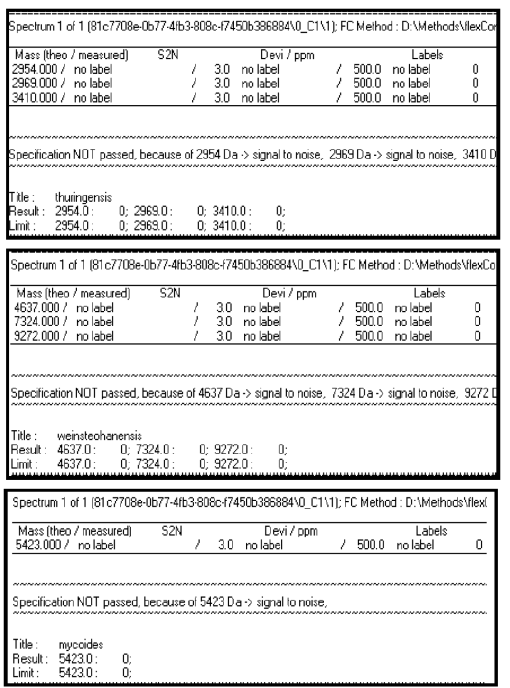
Figure 7. Results of FlexAnalysis algorithms for all the considered species, applied to an experimental spectrum of B. anthracis